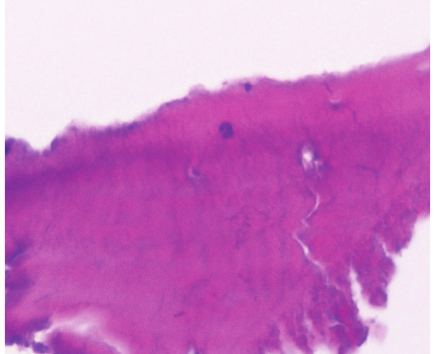
Figure 8: Histological examination in higher magnification of a sample harvested 24 months after surgery using PRF only shows extremely mature bone tissue (H-E